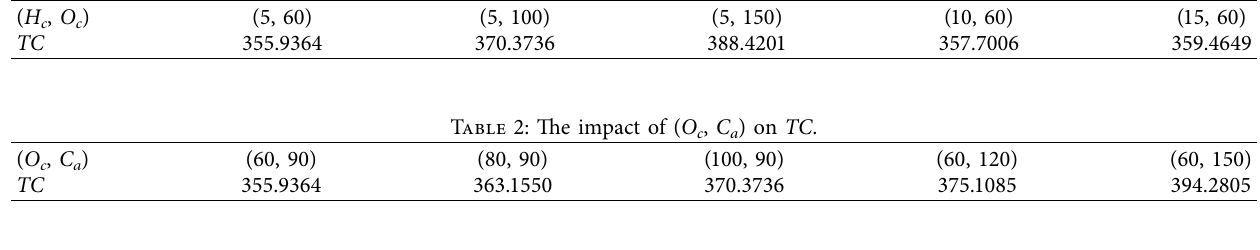
Table 3: The impact of ( S